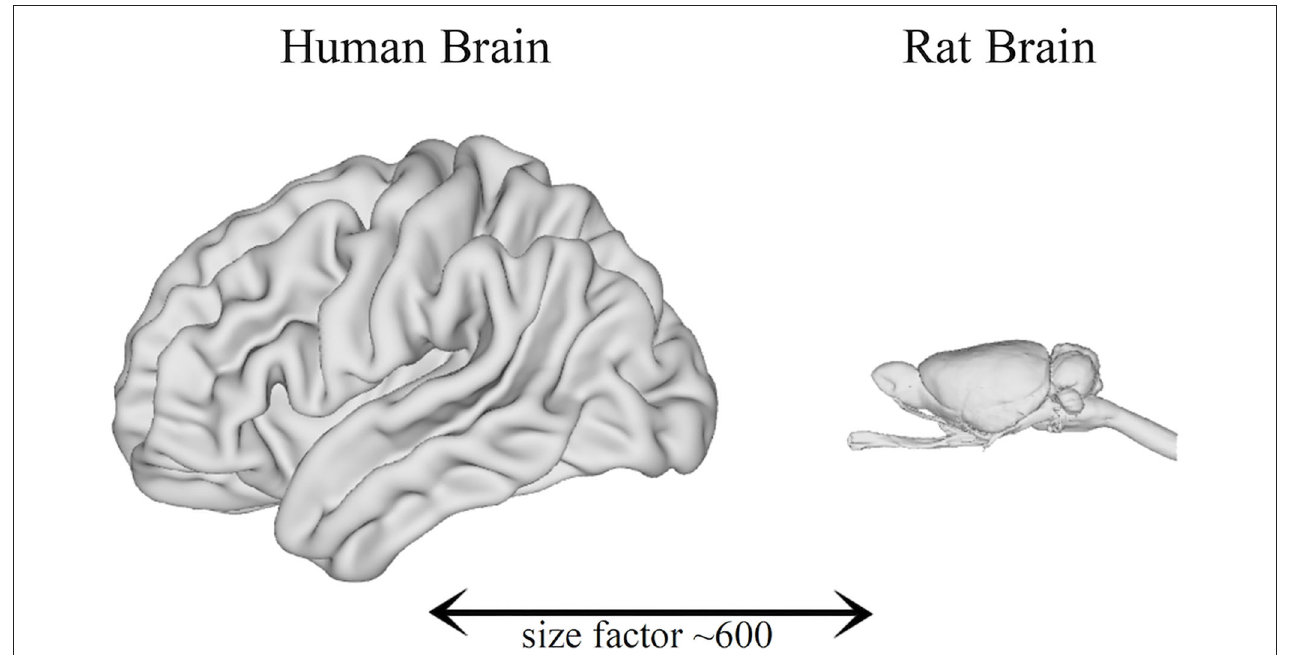
FIGURE 1 | Comparison between the brain size of humans and rats (Bakker et al.,